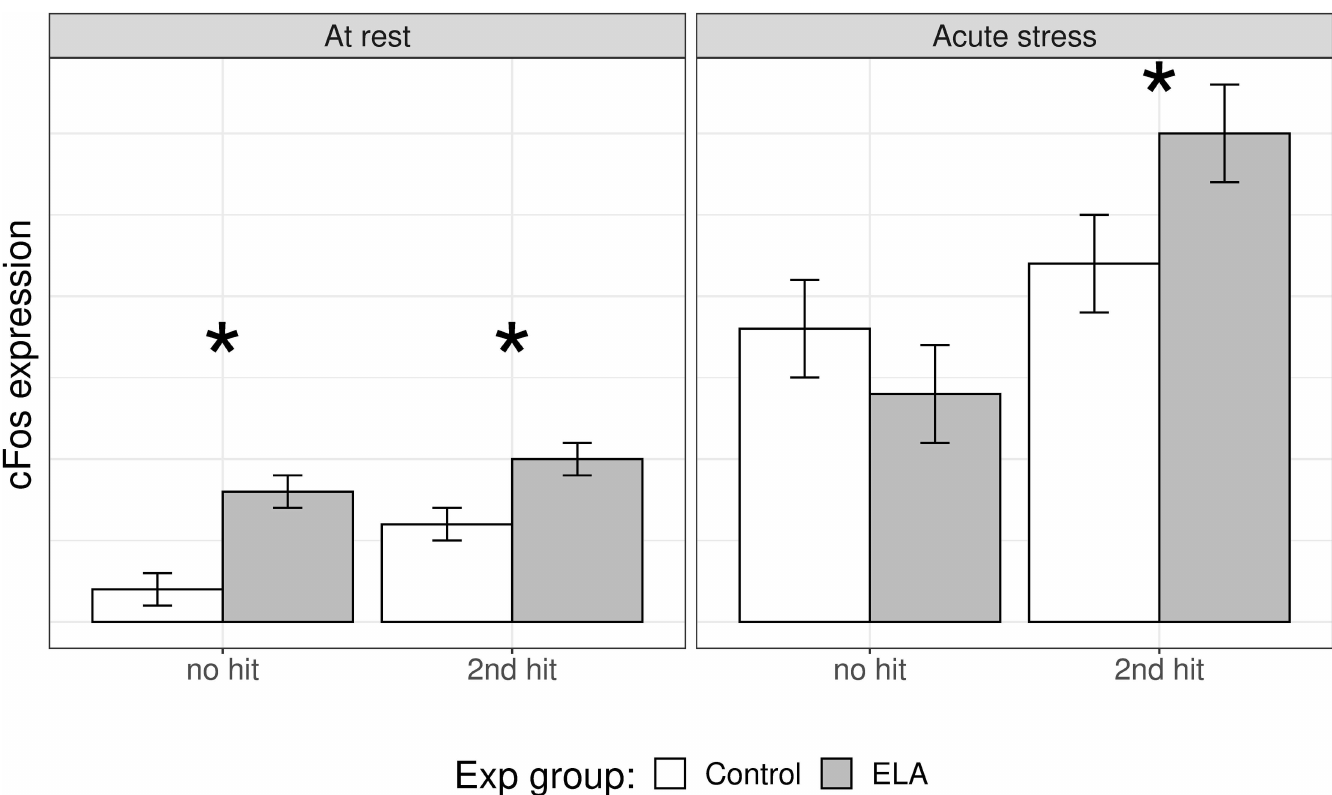
Fig 6. Summary interpretation of the results. Cartoon image of how to interpret effect sizes in absolute terms (y-axis, cFos expression, e.g. number of cFos+ cells). Significance levels identify the difference between control and ELA groups that we identified in our analysis (Fig 3). Of note, cFos expression levels are expected to be higher after acute stress than at rest, although this cannot be studied in the current